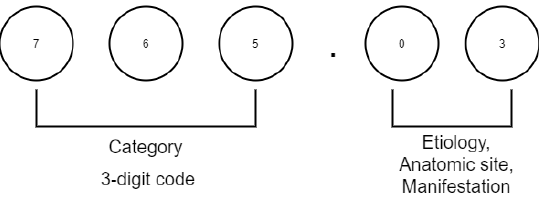
Figure 2. The format of ICD-9